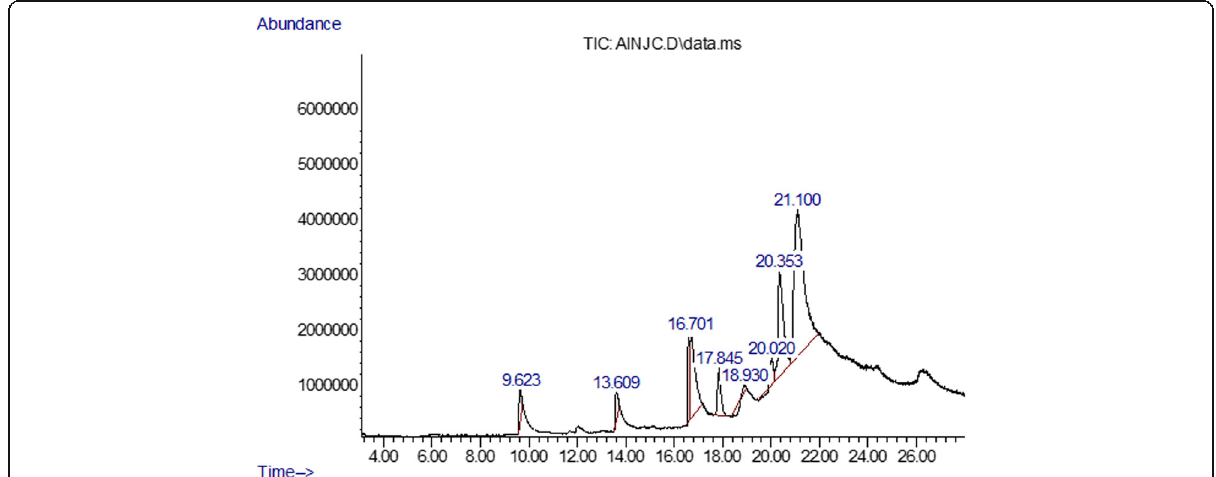
Fig. 10 Chromatogram of chemical profile of mixture of Nicotiana tabacum plus Jatropha curcas plus Azadirachta